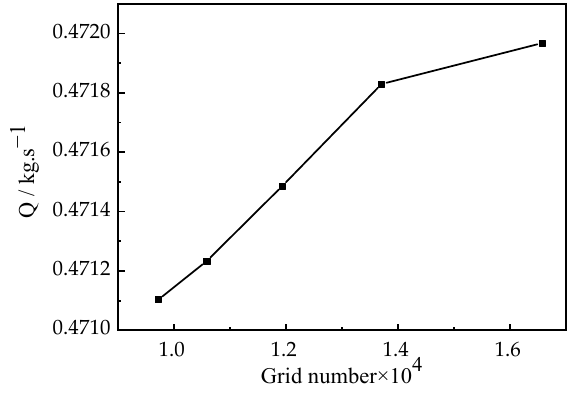
Figure 4. Grid independence test.